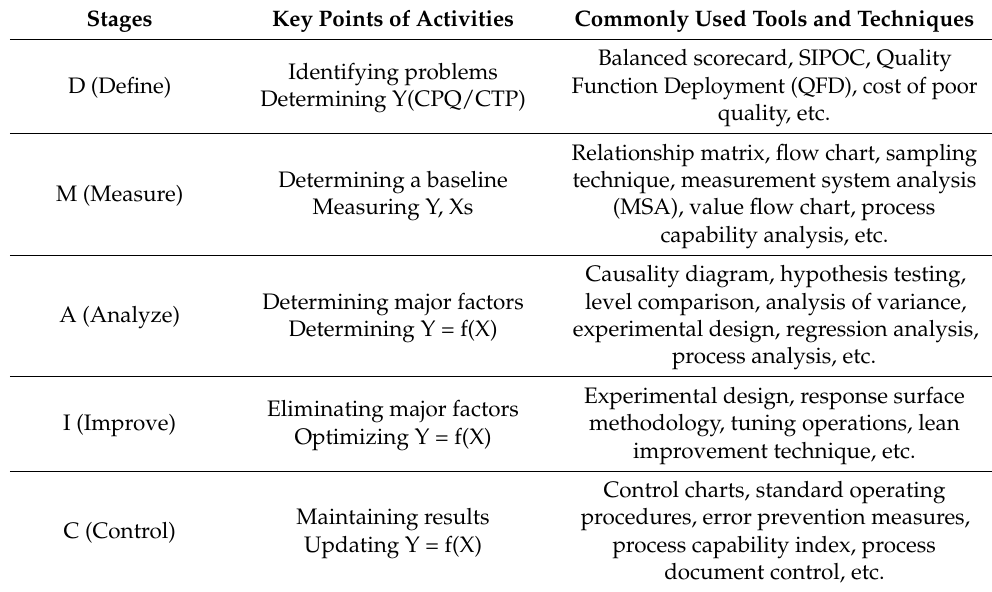
Table 1. Key points and tools of DMAIC process